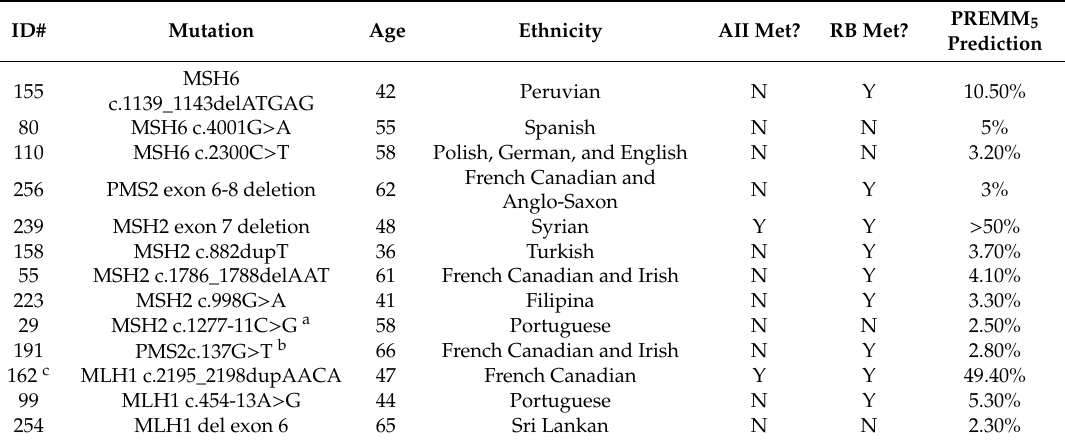
Table 1. Clinical information for germline-positive individuals.